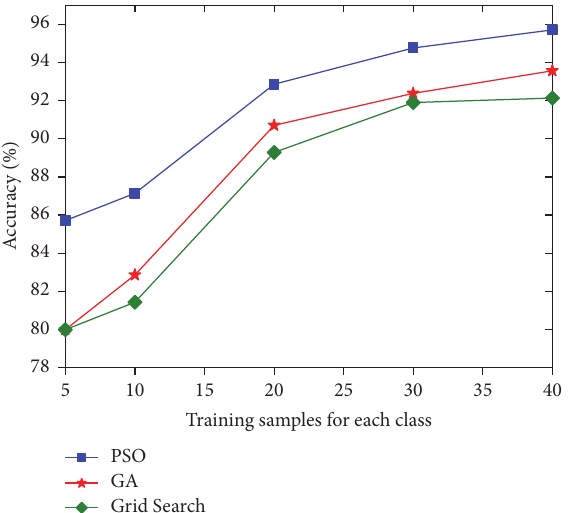
Figure 12: The diagnostic accuracy based on the LS-WSVM opti- mized by PSO, GA, and GS,